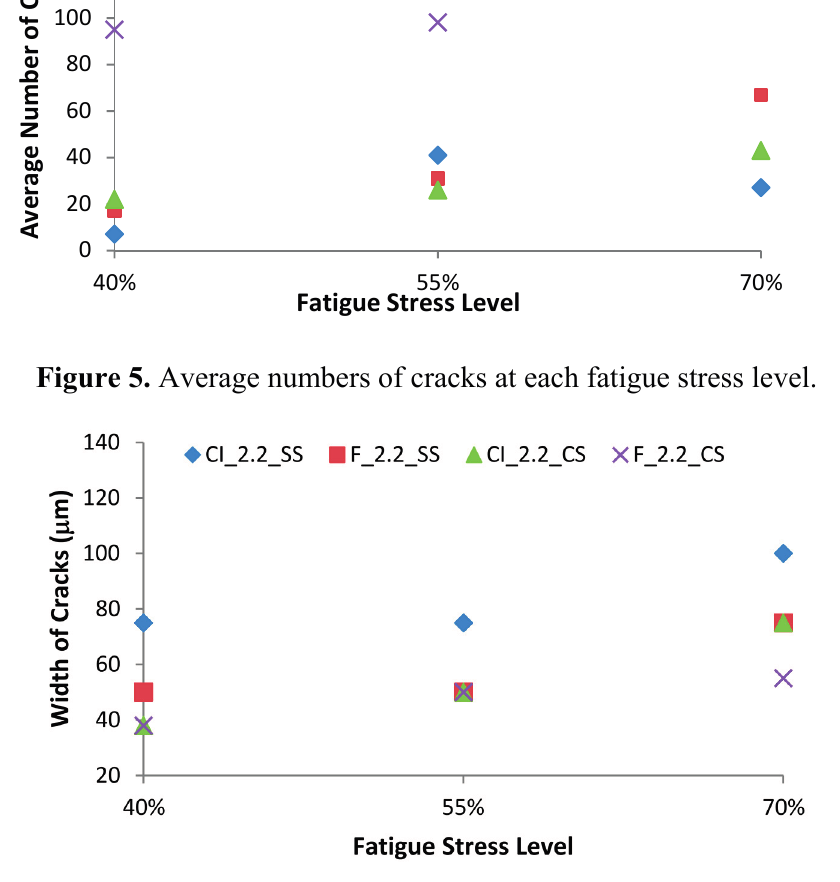
Figure 6. Crack Widths at each fatigue stress